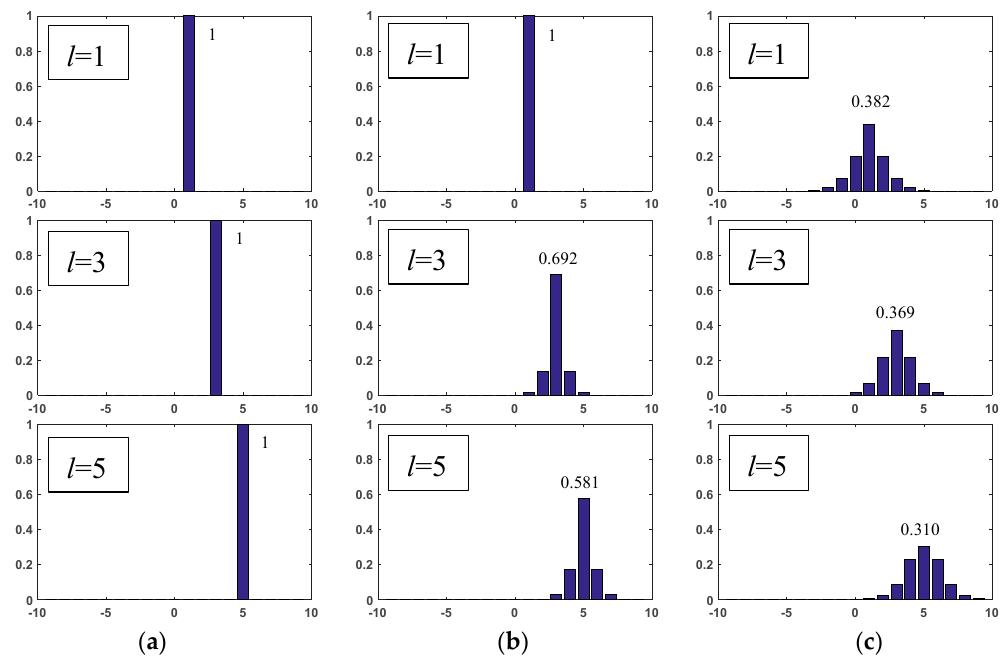
Figure 6. Variance of crosstalk through the weak-to-strong turbulence with transmission distance of ( a ) 1 km, ( b ) 5 km and ( c ) 10 km, with adaptive compensation.